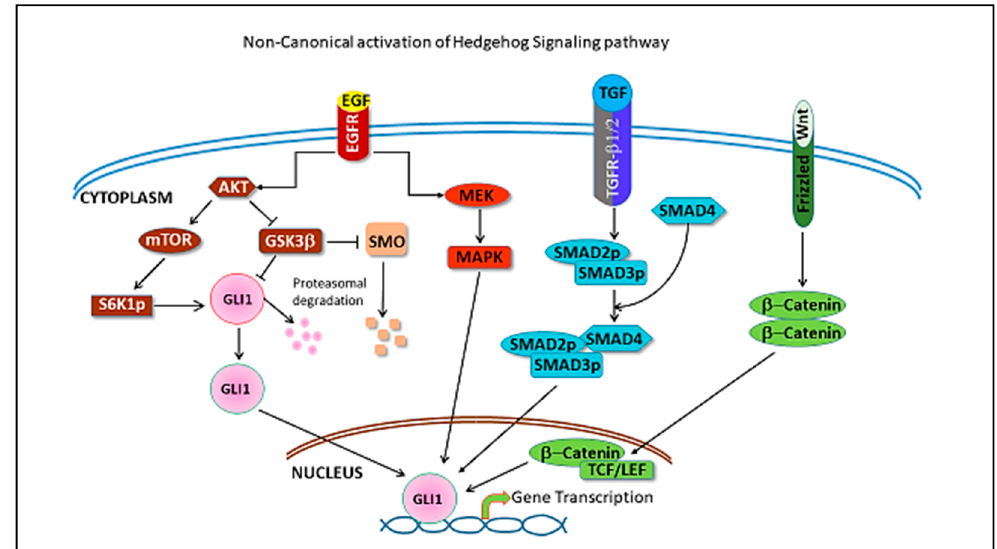
Figure 2. Figure depicts pathways that cross-talk with Hh pathway leading to its non-canonical activation. EGF(Epidermal growth factor) signaling pathway activates GLI mediated transcription through pAKT, as well as MAPK activation (shown in brown/red). TGF β activation is mediated through SMAD2/3/4 complex (shown in blue) and Wnt signaling pathway activation is through b-catenin/TCF-LEF (shown in green).